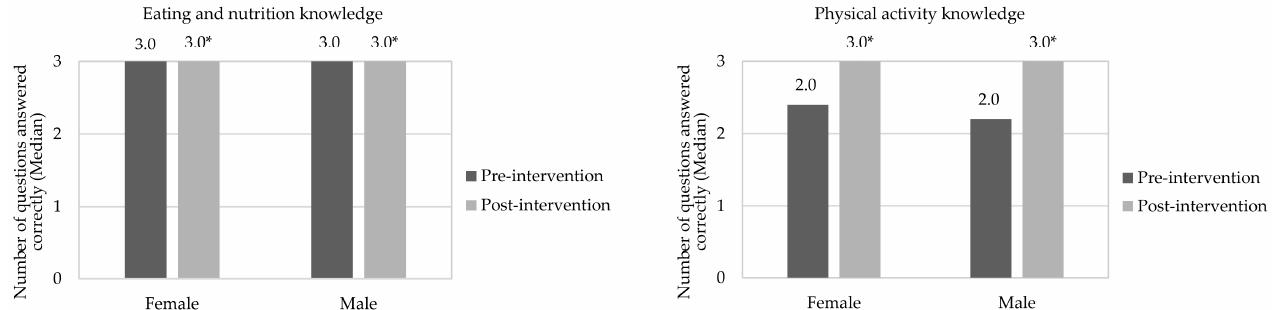
Figure 4. Correct answers to questions about knowledge of eating, nutrition, and physical activity in the pre- and post-intervention stages, considering the children’s genders. * Indicates significant difference by Wilcoxon Test ( p -value < 0.05), in relation for correct answers to questions of the questionnaires about knowledge in eating, nutrition, and physical activity in the pre- and post-intervention stages. The assessment was performed between the same gender. Grade scale: 1—low, 2—good, and 3—great.